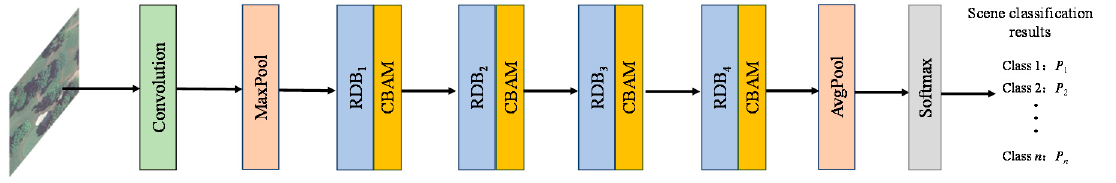
Figure 1. Structure of the residual dense network (RDN) based on channel-spatial attention (RDN + channel-spatial attention module (CBAM)).